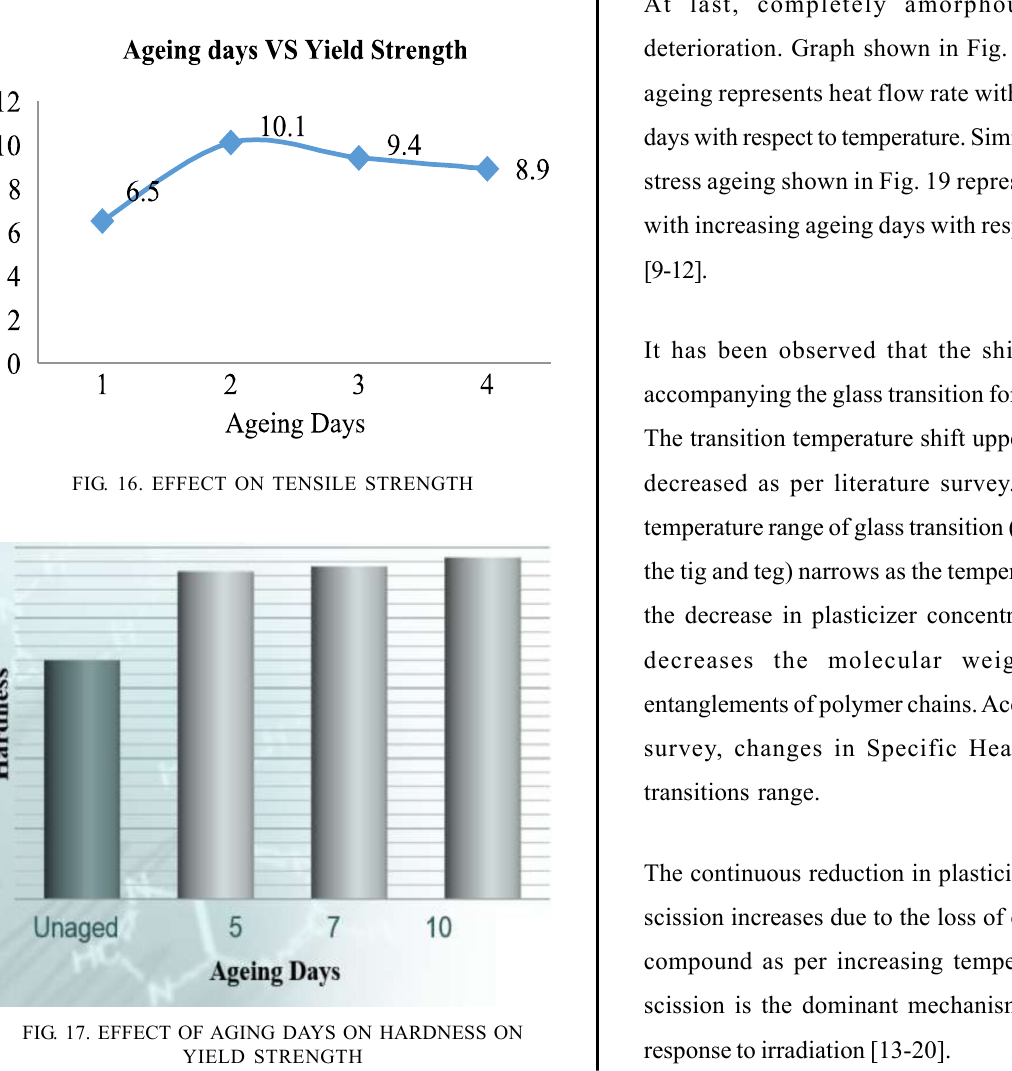
FIG. 15. EFFECT OF AGEING DAYS